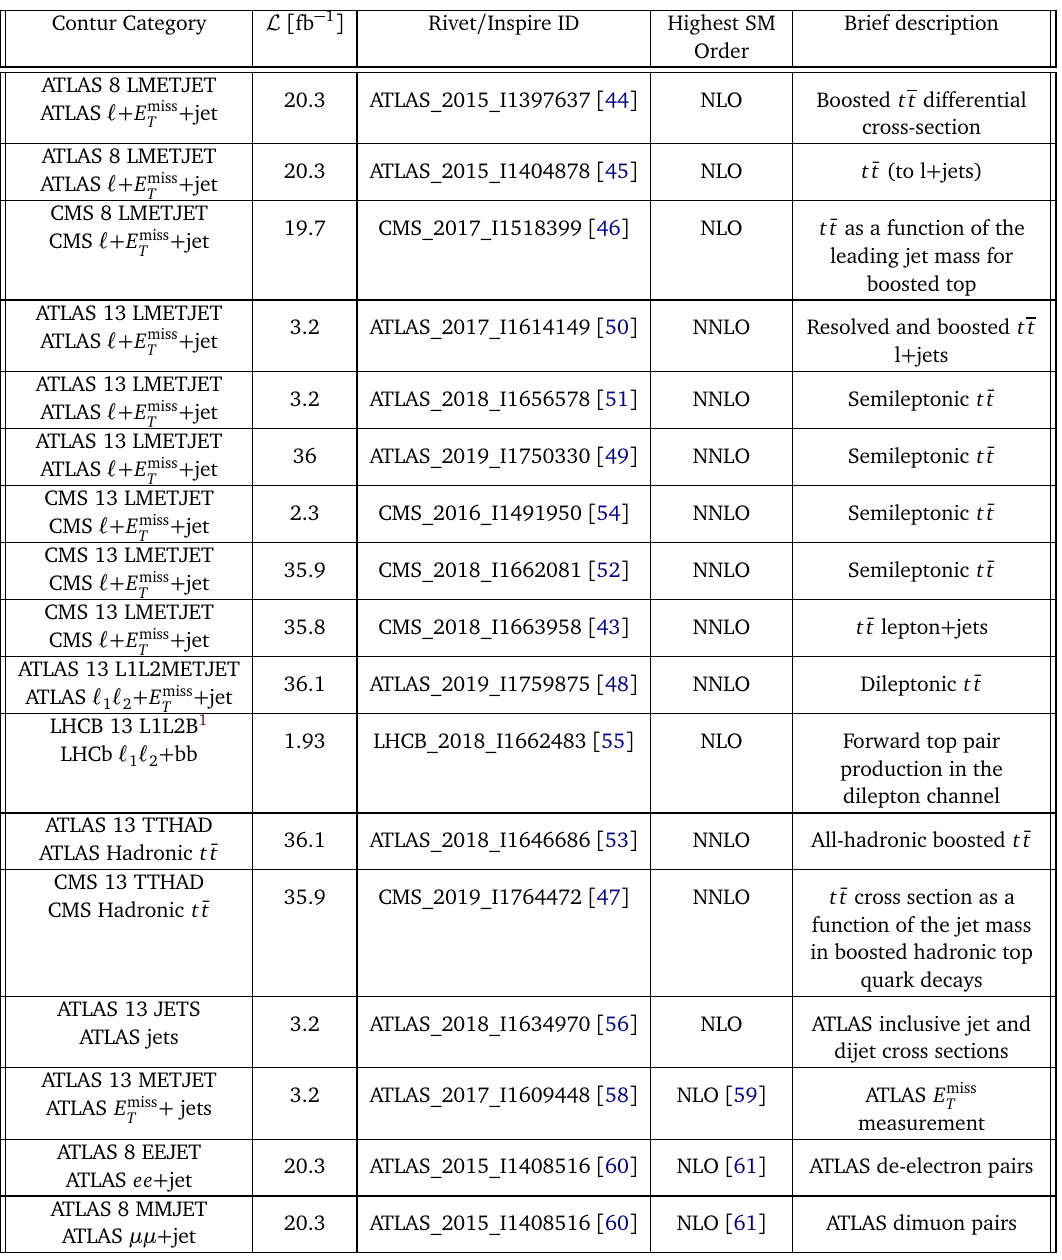
Table 1: Table of the Rivet routines used for the limit-setting scan. Only routines where we have higher-order theory predictions are listed. The number in the Contur category indicates the centre-of-mass energy. The calculations are performed by the authors unless otherwise